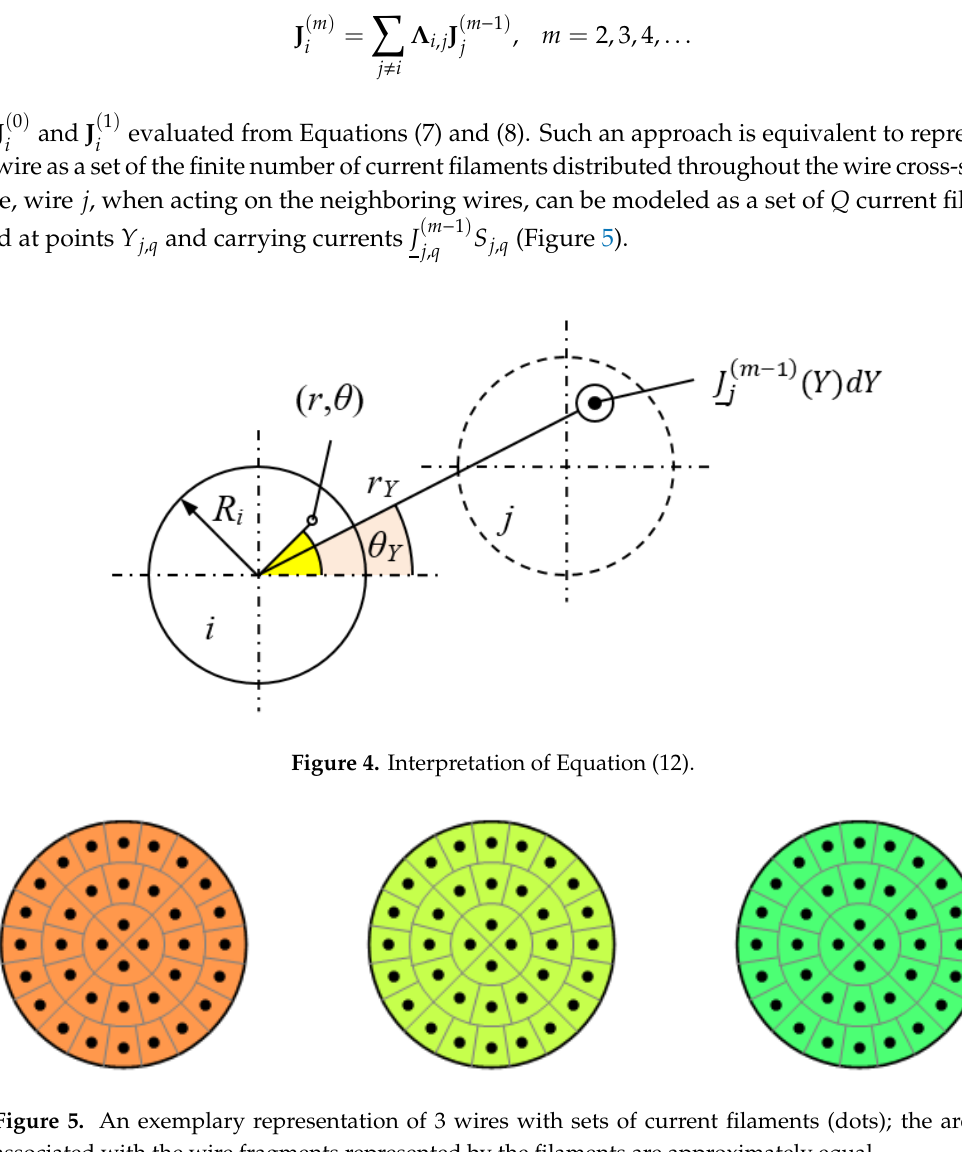
Figure 5. An exemplary representation of 3 wires with sets of current filaments (dots); the areas associated with the wire fragments represented by the filaments are approximately